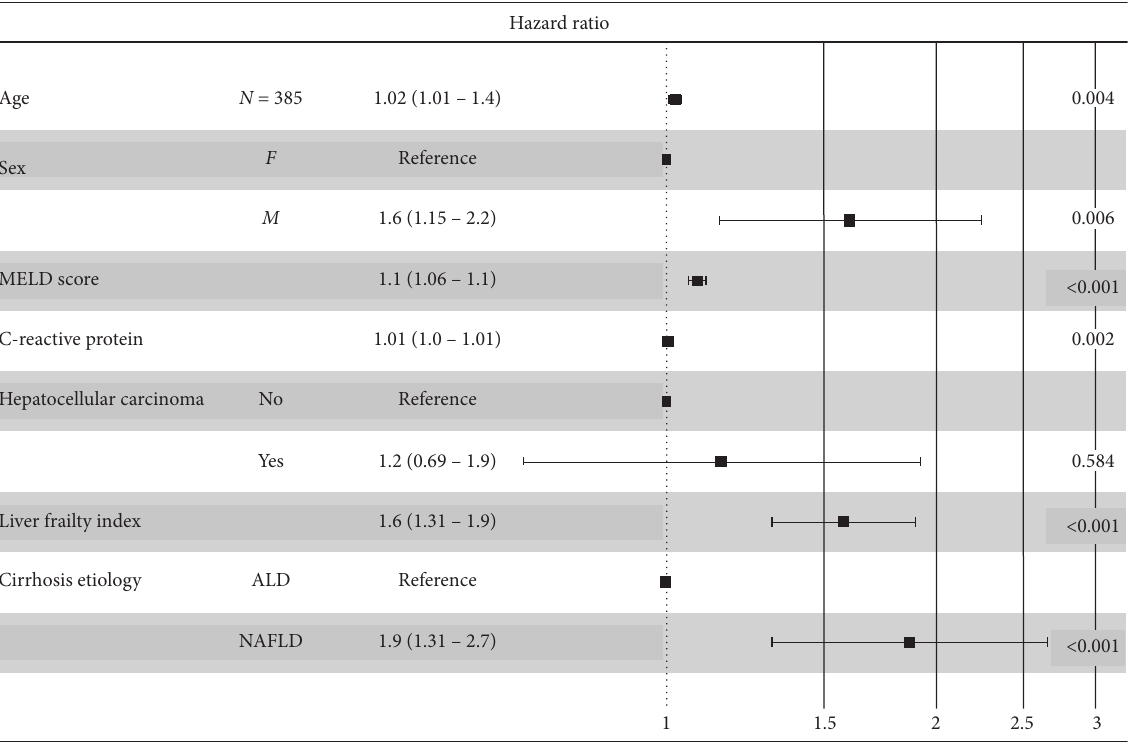
Figure 3: Forest plot of the adjusted Cox model for the predictors of death or LT from the RH7 cirrhosis registry (ALD � 280, NAFLD � 105), events n � 188, global p value (Log-rank) < 0.0001, AIC � 1072, and concordance index �